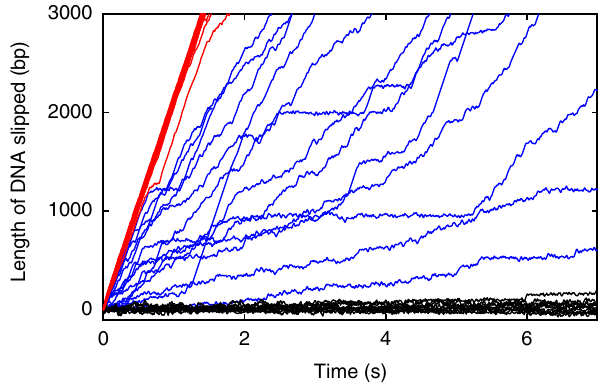
Fig. 2 Measurements of DNA gripping by the motor and slipping. Representative measurements of length of DNA that slips out of the capsid vs. time with no nucleotides (red lines, average force = 3 pN), 0.5 mM γ -S- ATP (black lines, average force = 5 pN), or 0.5 mM ADP (blue lines, average force = 5 pN). Each line is a separate slipping event. Note that many red lines lie nearly on top of each other, and similarly for the black lines. The total numbers of solution exchange events and complexes measured for each condition, including ones not plotted here, are given in the results section of the